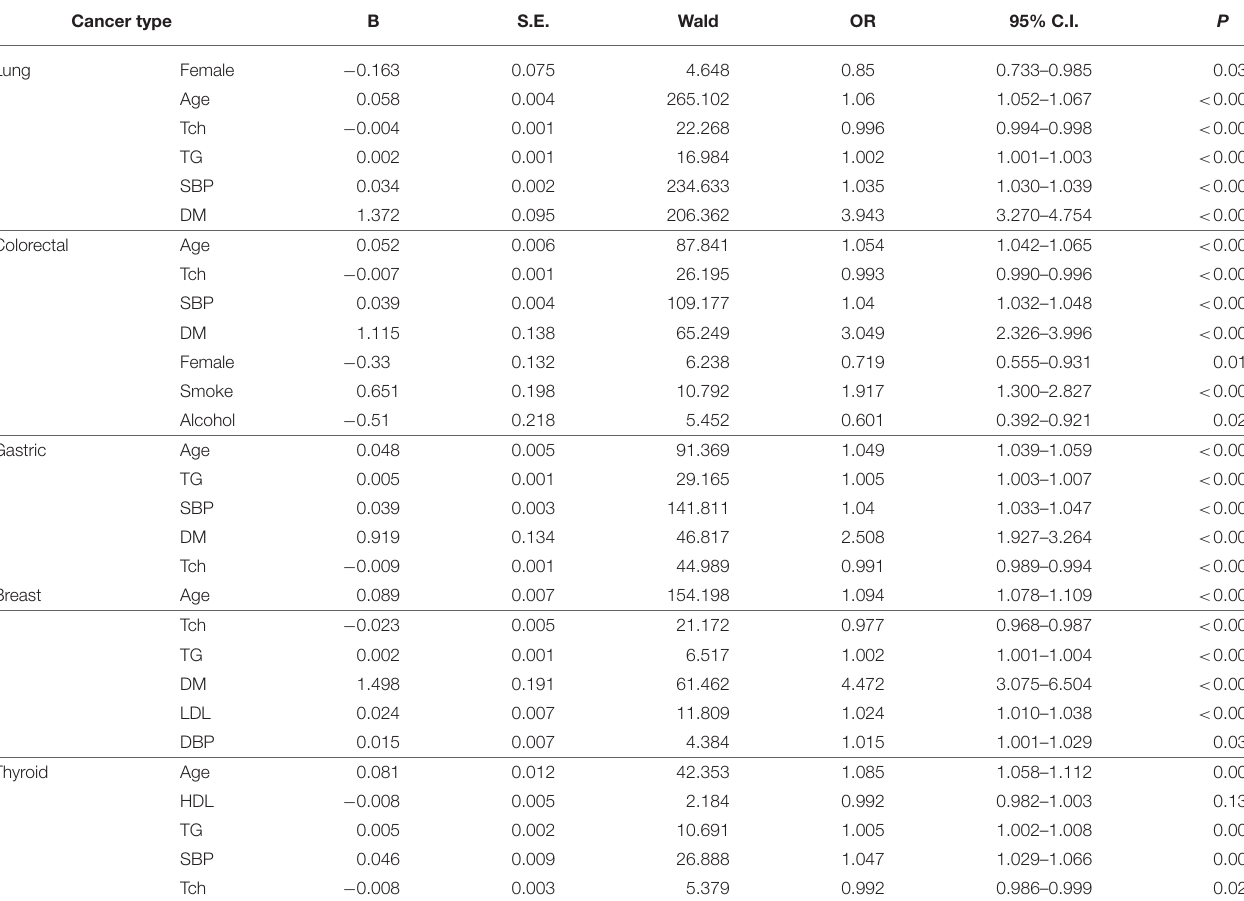
TABLE 3 | Cardiovascular risk factors among the different cancer sites. Cancer type B S.E. Wald OR 95%